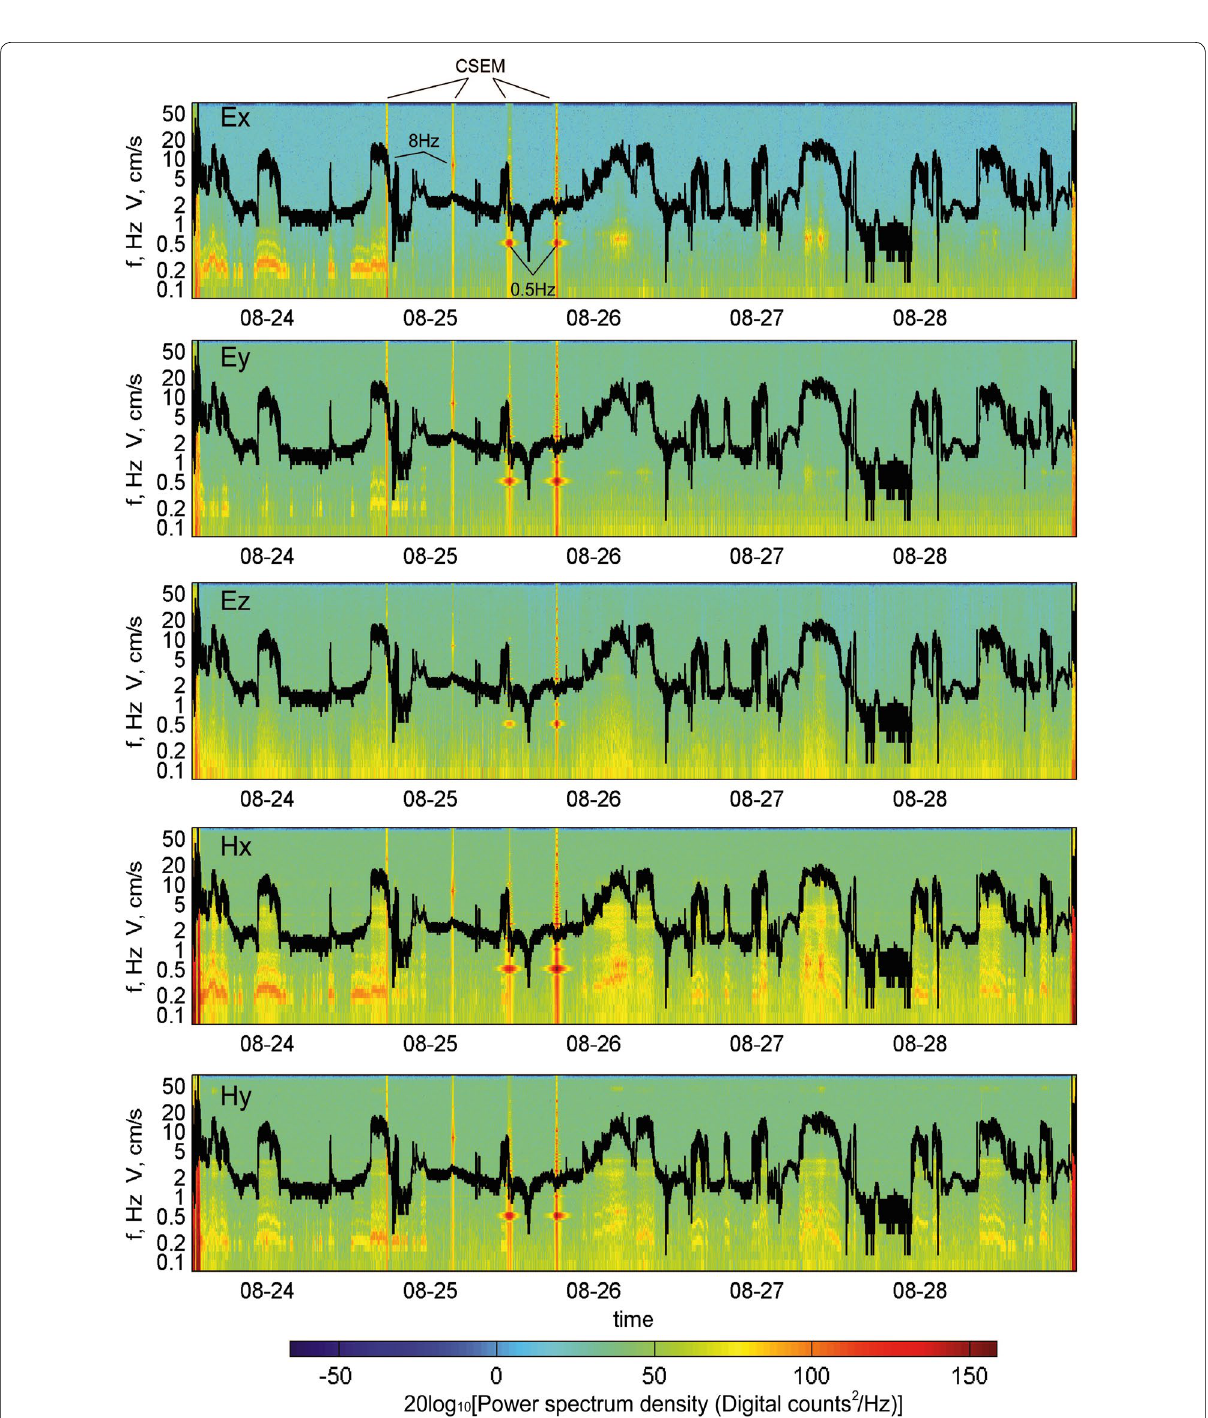
Fig. 3 Results from the short-time Fourier transformation (STFT) analysis of 5 days worth of five EM components and current speeds from site SH-R11 in the Shenhu area. The subplots are the Ex, Ey, Ez, Hx, and Hy components. Colors indicate the power spectrum density of the EM components. Units of the color bar are in 20log 10 (digital counts 2 per Hz). The black line indicates current speeds in